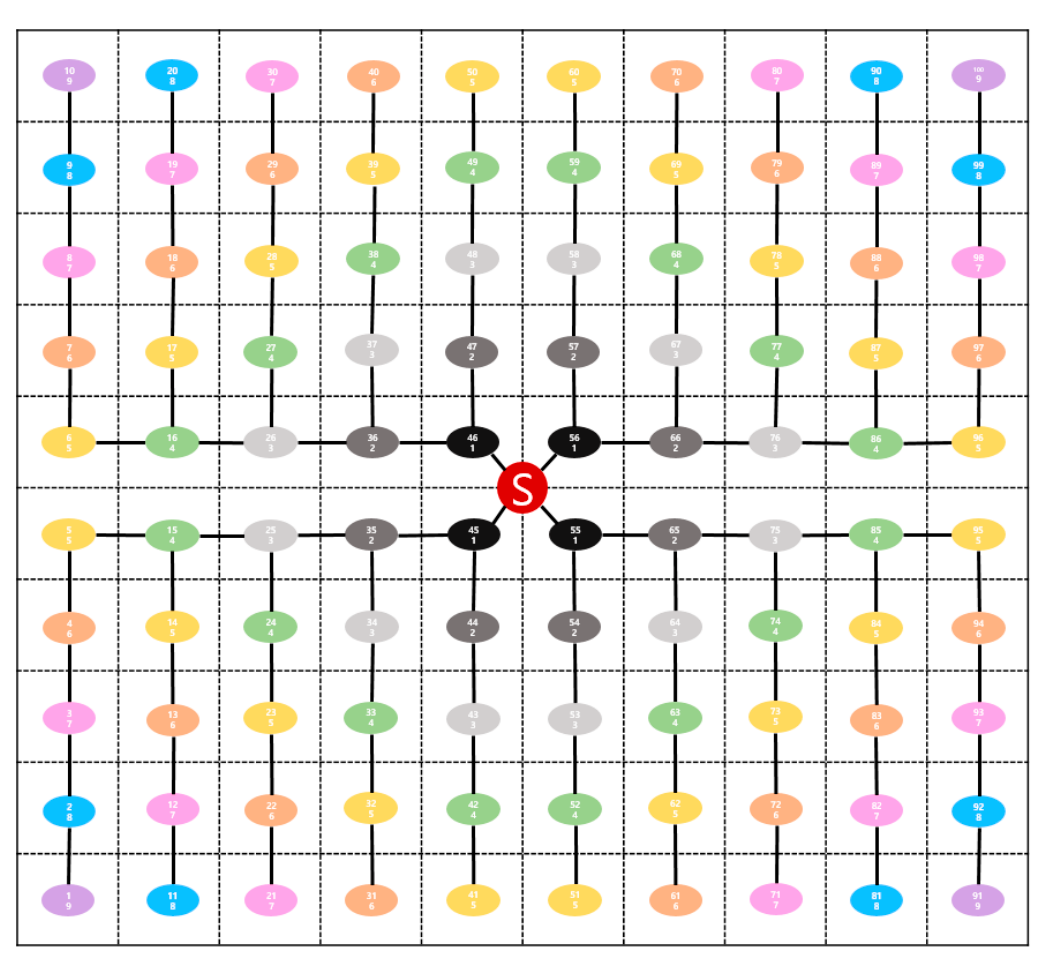
Figure 6. Sample topology for experiments of deriving buffer threshold equation.